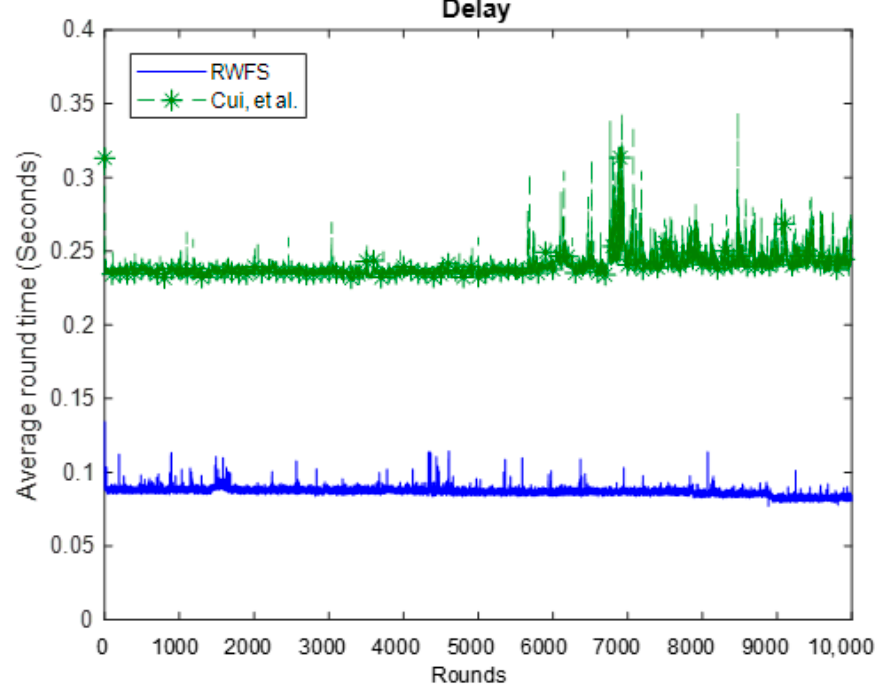
Figure 10. The delay analysis between RWFS (the proposed scheme) and the Cui et al. scheme. The average execution time for each round was measured for a total of 10,000 rounds.